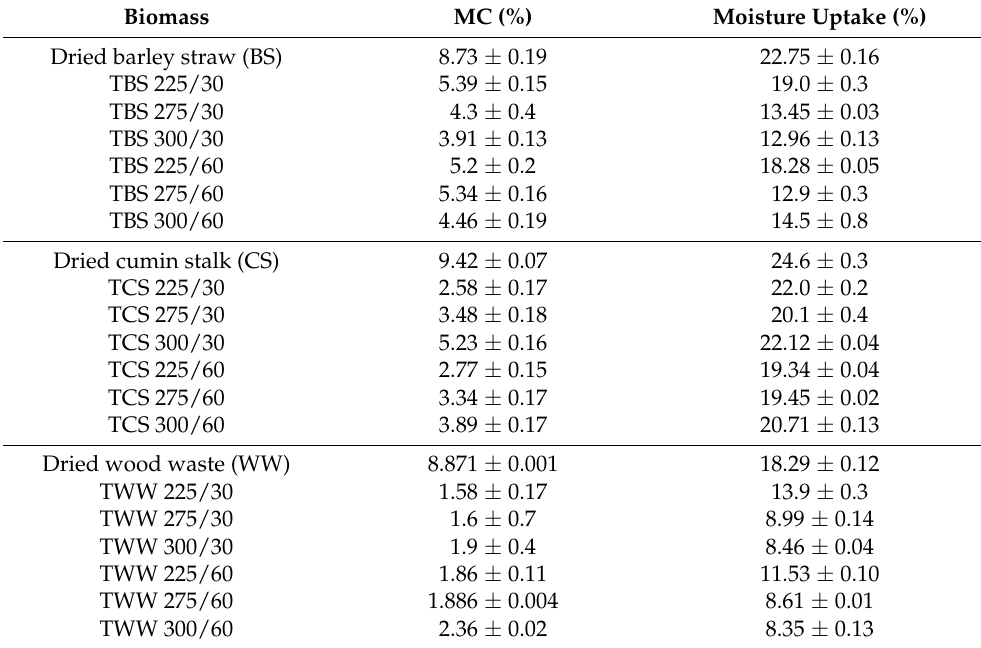
Table 3. Moisture content (wt.%) and moisture uptake (%) of raw and torrefied biomasses.